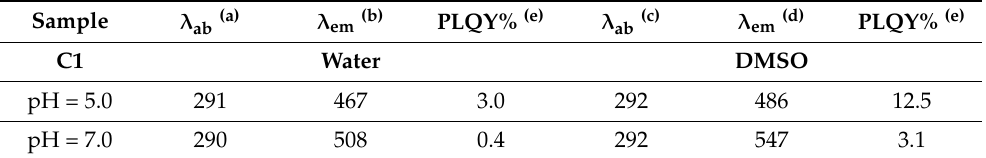
Table 1. Absorption and emission maxima of C1 in slightly acidic (pH = 5.0) and neutral (pH = 7.0)